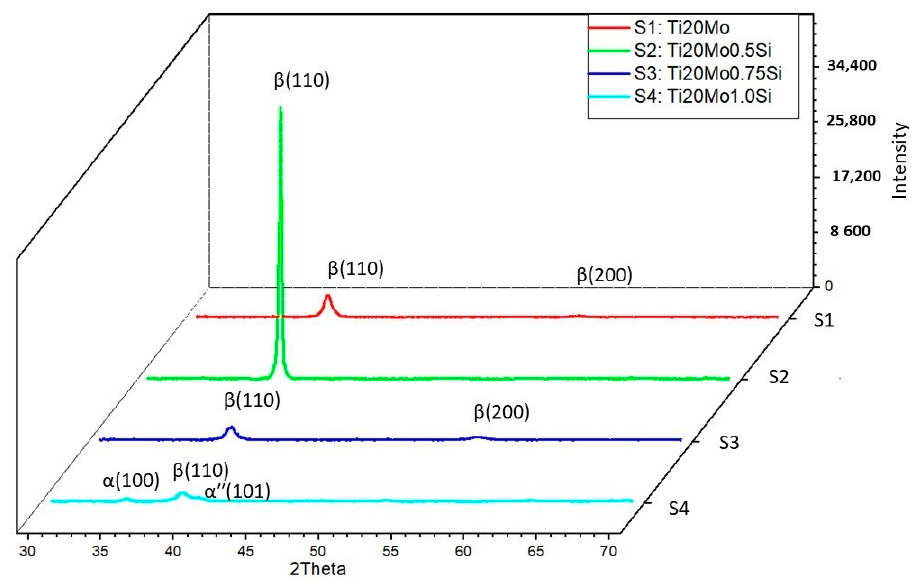
Figure 2. XRD patterns Ti–Mo–Si alloys: S1—Ti20Mo, S2—Ti20Mo0.5Si, S3—Ti20Mo0.75Si,